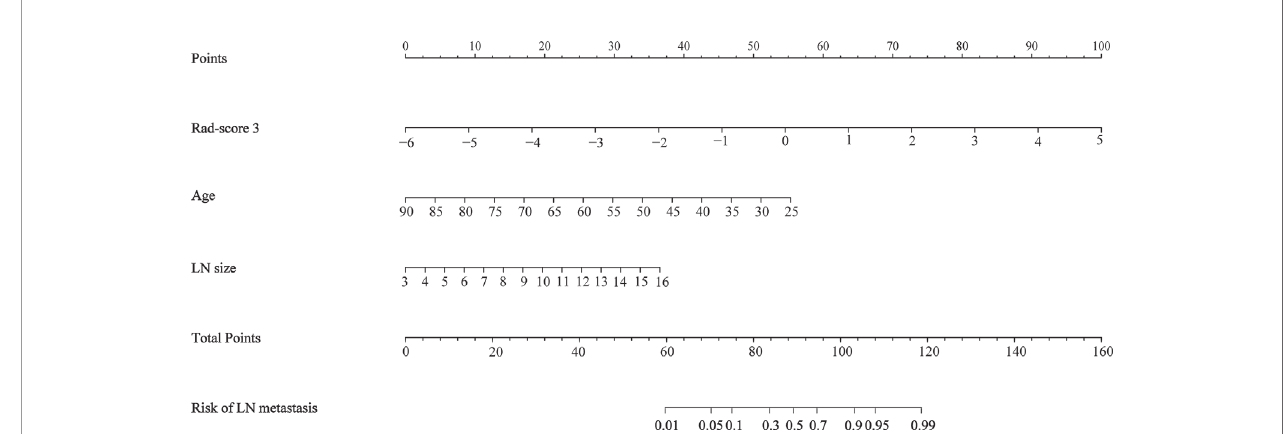
FIGURE 4 | Radiomics nomogram incorporating the rad-score 3, age, and the LN size.